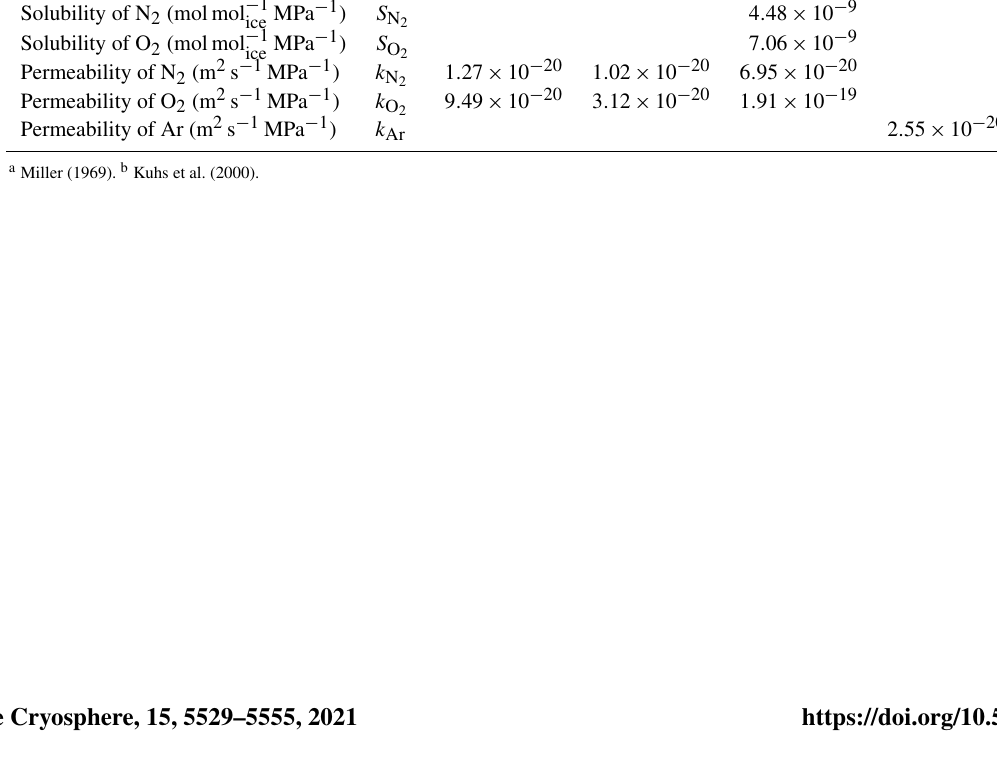
IkFk01 Salm01 IkFk05 Ar(I) Ar(II) 6.48 a N 2 O 2